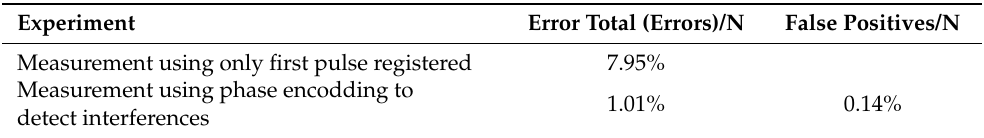
Table 2. Error percentage in the